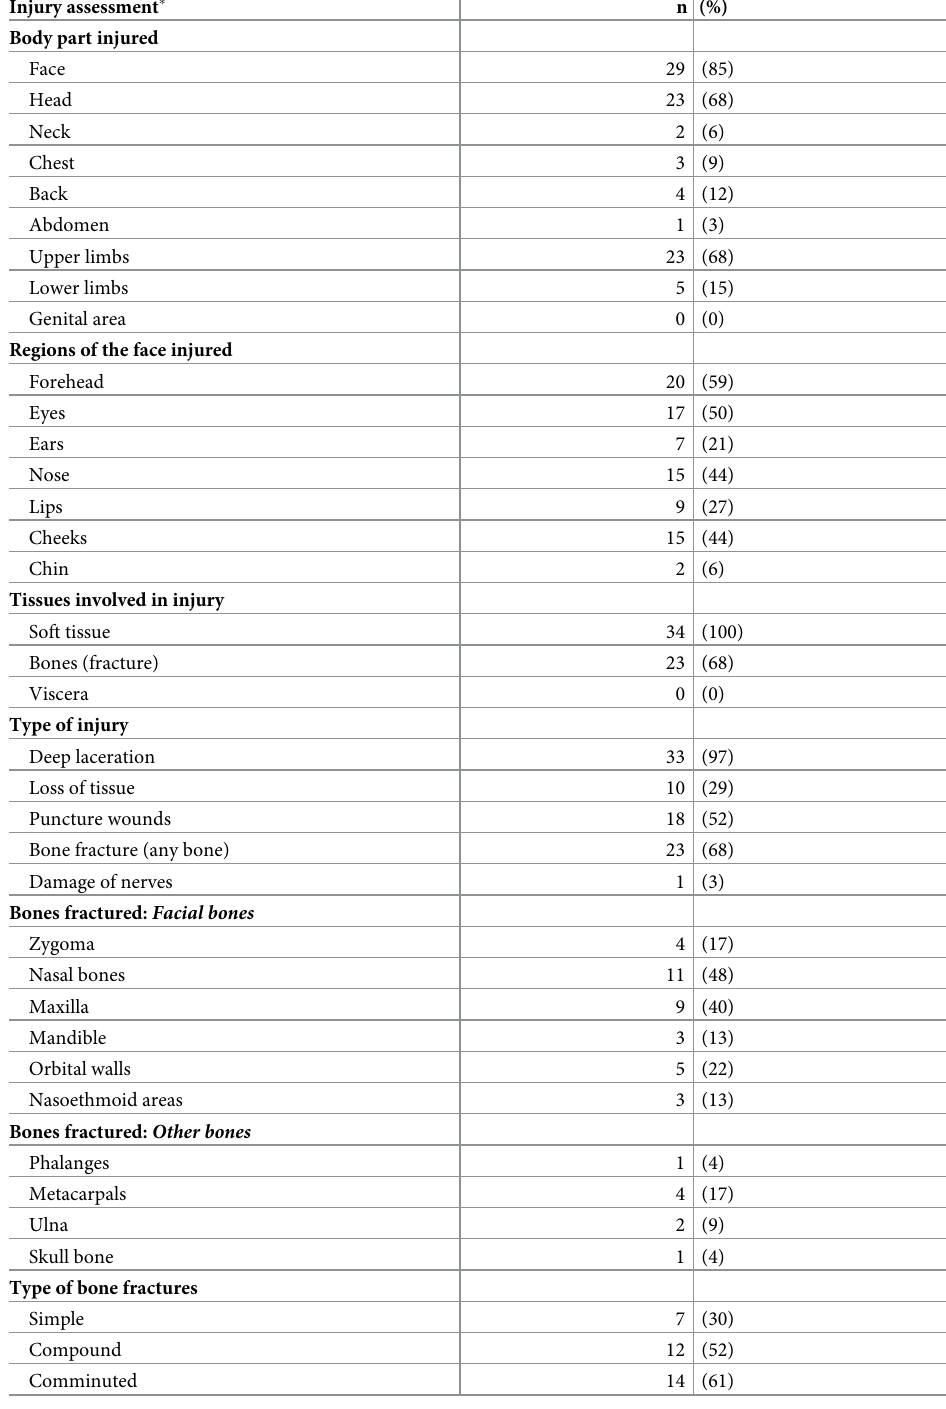
Table 3. The description of the injury sustained by the victims of bear attacks who received care at the Jigme Dorji Wangchuck National Referral Hospital, Bhutan from 2015 to